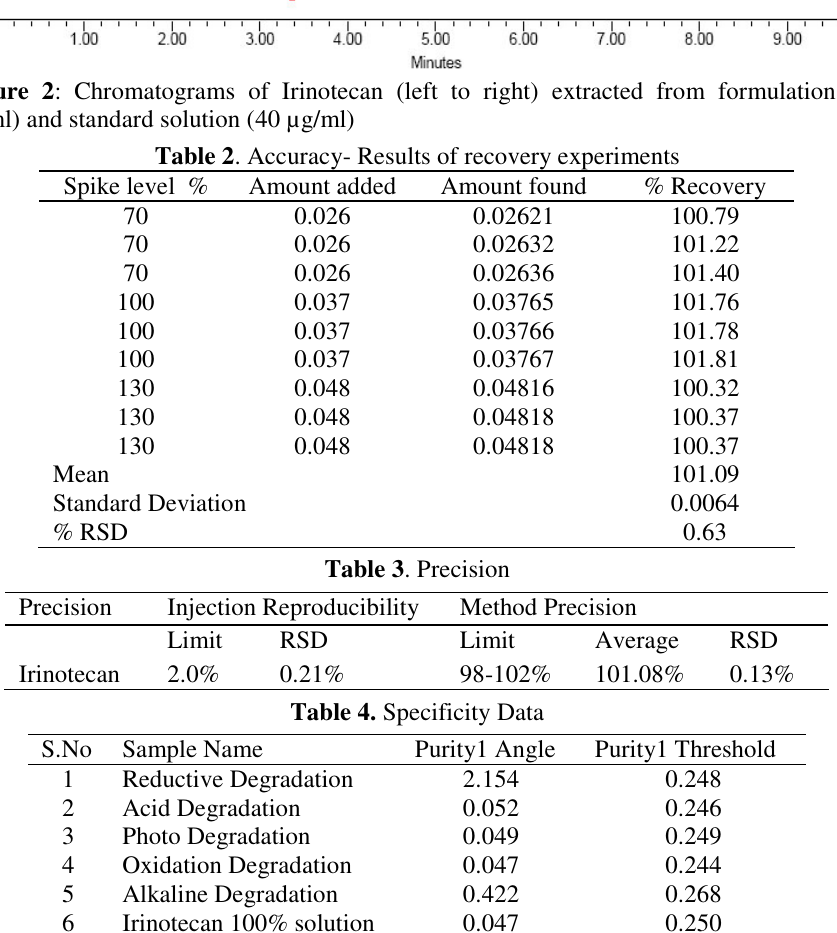
Table 4. Specificity